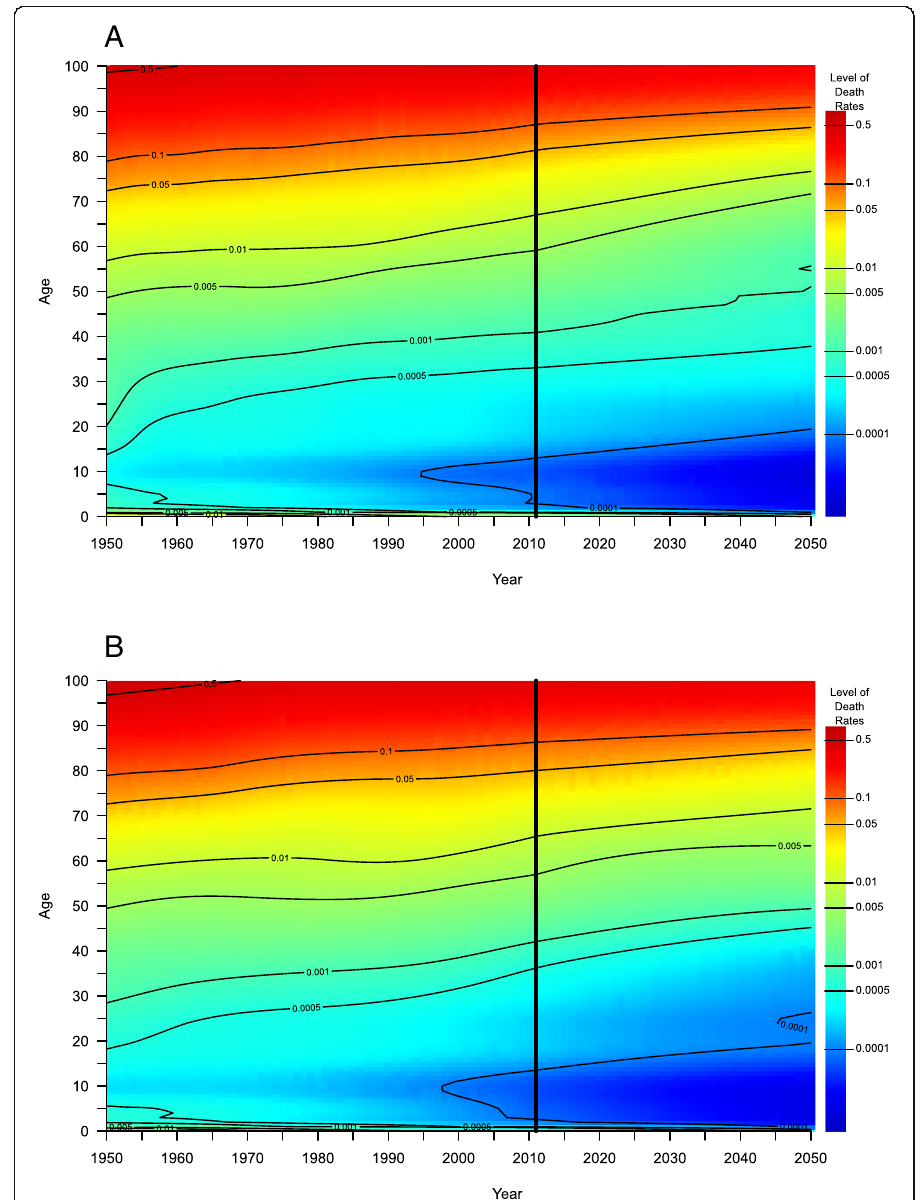
Fig. 6 Death rates by single age; observed in the calendar years 1950 to 2011 and forecasted with the exponential core model in the years 2012 to 2050 for women in the UK ( top ) and Denmark ( bottom ). The transition from observed to forecasted death rates is illustrated by the vertical black line in both